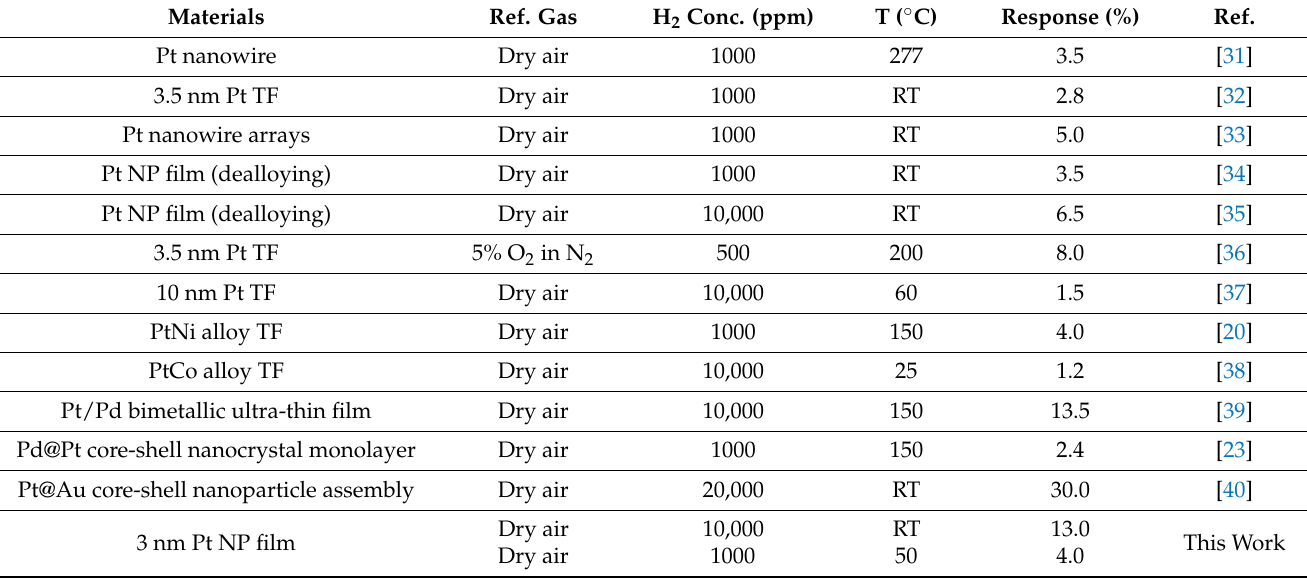
Table 1. Performances of resistive-based metallic hydrogen sensors [20]. Modified and updated from the Journal of Alloys and Compounds, 892, N. Kilinc, S. Sanduvac, M. Erkovan, Platinum-Nickel alloy thin films for low concentration hydrogen sensor application, 162237, Copyright (2022), with permission from